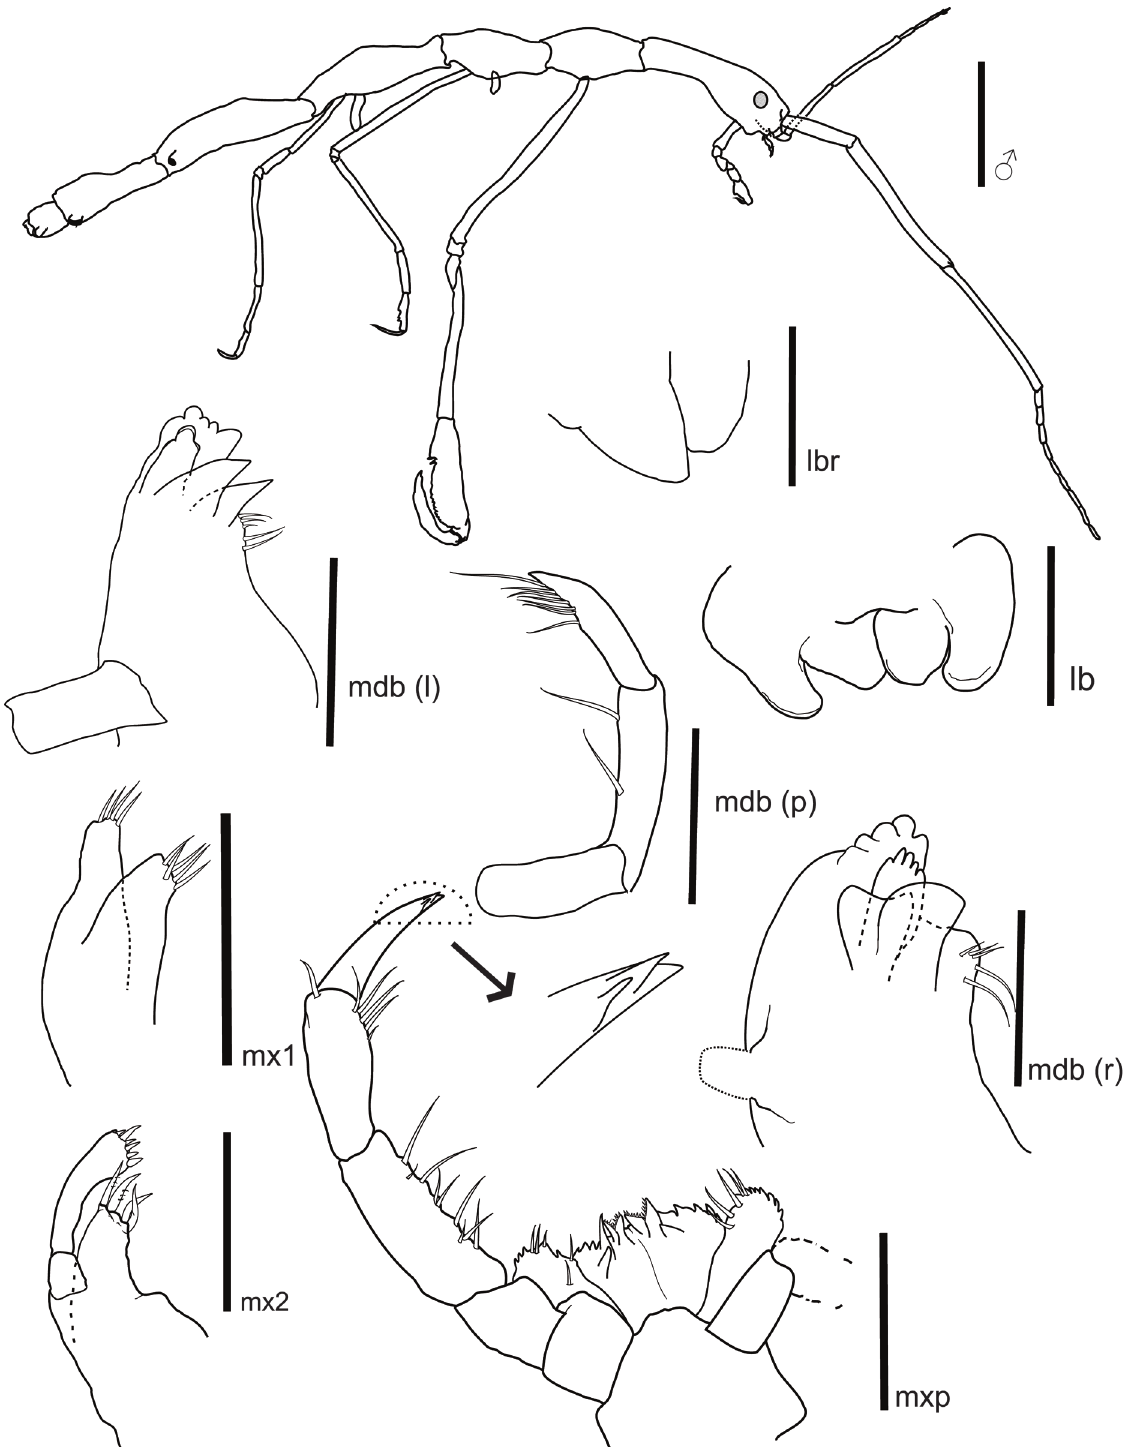
Fig. 1. Hemiproto wigleyi (McCain, 1968). Male, 8.36 mm, Campos Basin, RJ (MNRJ 25515). Scale bars: habitus = 0.5 mm; lb, lbr, mx1, mx2, mdb(l), mdb(r), mxp = 0.1